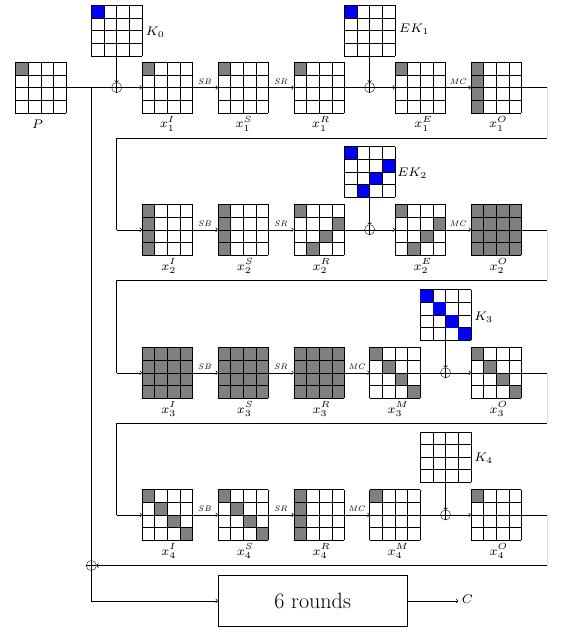
Figure 13: Key-recovery attack for Dual-AES-PRF 4 , 6